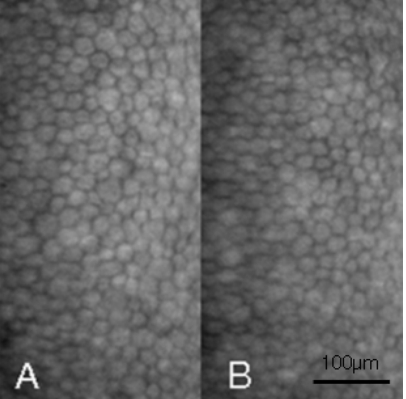
Figure 3. The clear cornea appearance with phakic intraocular lenses one week postoperatively. ( A ) The external eye image of right eye. ( B ) The external eye image of left eye.